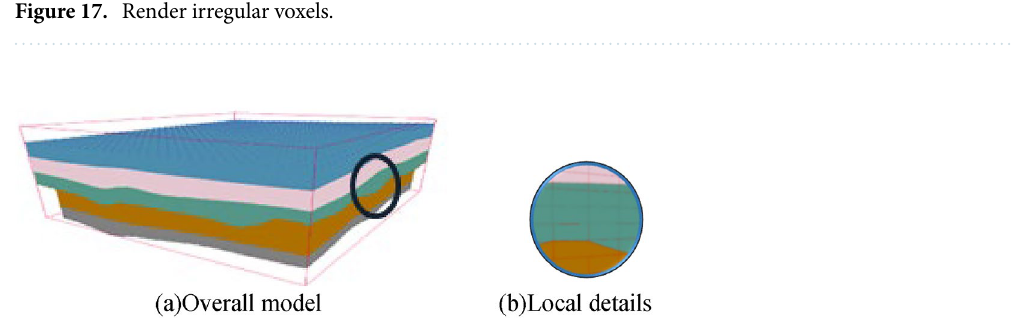
Figure 18. Overall model and local